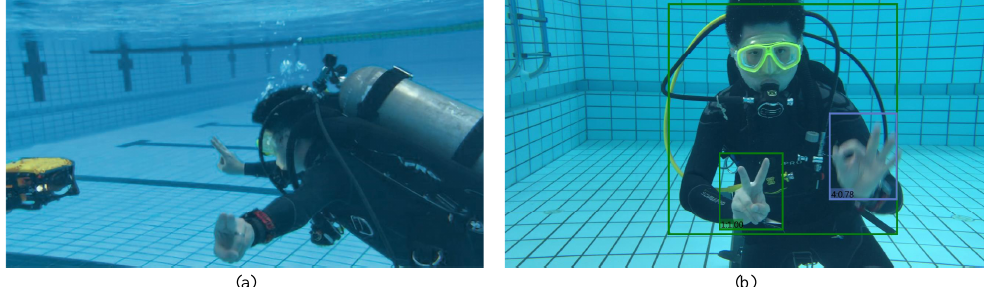
Figure 16. Outfield experiment results. ( a ) The gesture interaction scene. ( b ) The results of ges- ture